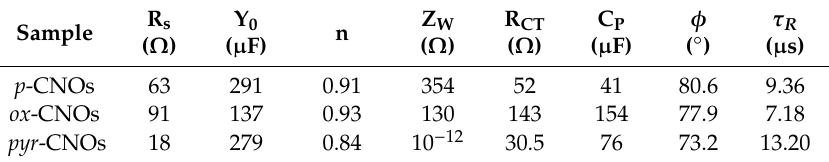
Table 4. Electrochemical impedance spectroscopy (EIS) parameters that were determined for the GCE electrode that was modified with the functionalized and non-functionalized